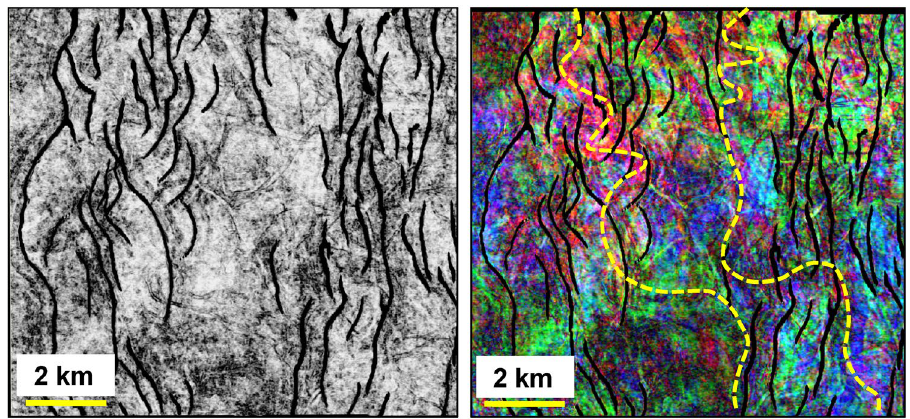
log. Blending of two frequencies ( c ) can be used to differentiate thick sands from thin sands. Here, red color indicates 20 Hz, i.e., thicker sands, whereas green color indicates 45 Hz, i.e., thinner sands